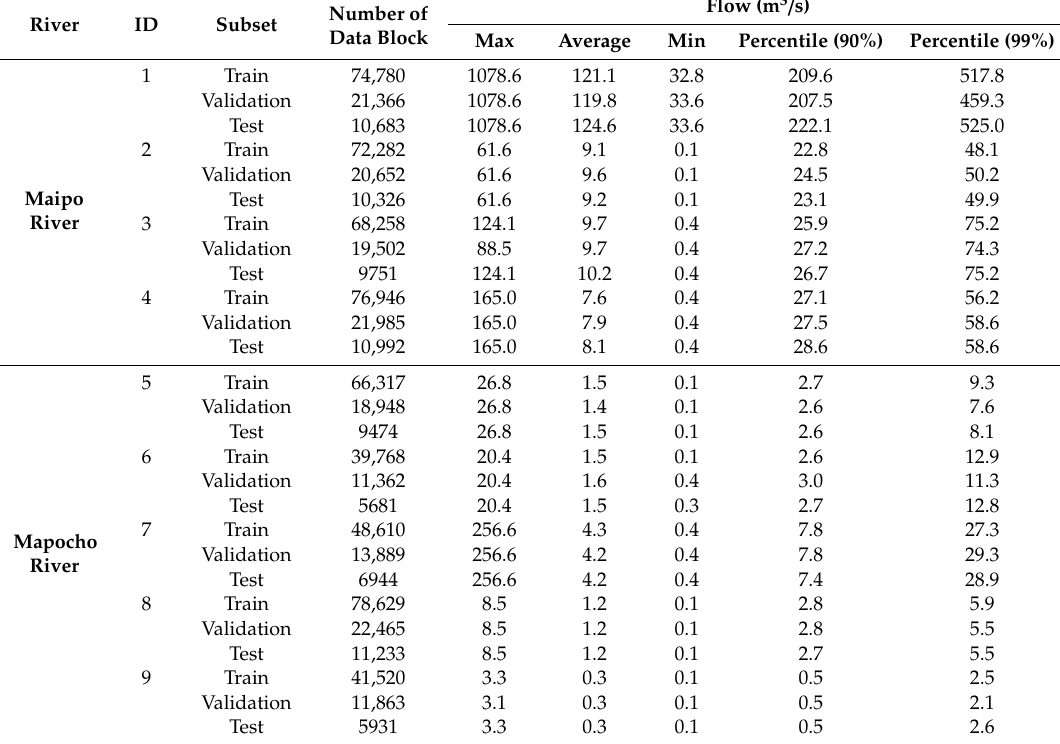
Table 2. Summary of hydrological features of the train, test and validation subsets for each of the studied